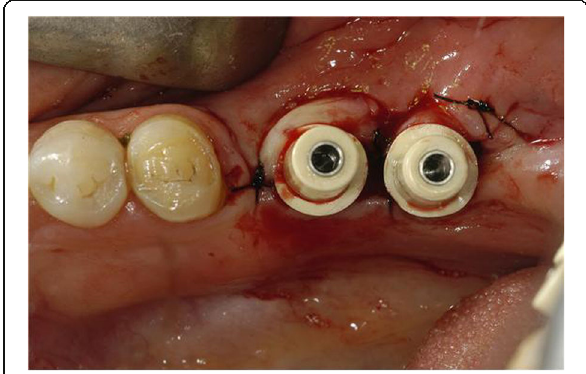
Fig. 1 A patient planned with placement of immediate loading implant in #36 and #37. Planning to place Pitt-Easy Bio-Oss® implant, perform resin restoration using A.G.T®